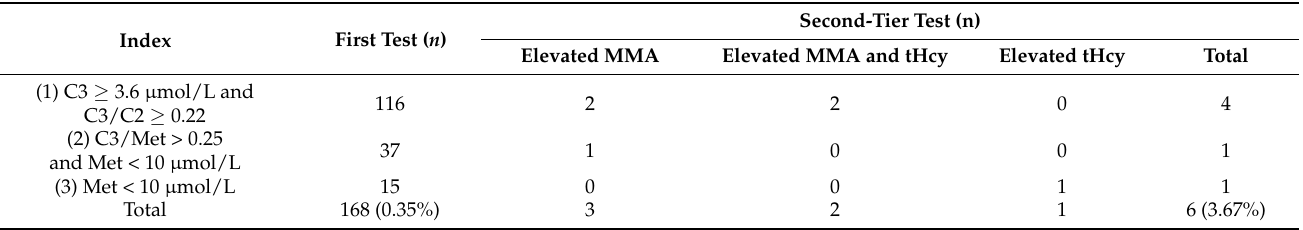
Table 3. Retrospective screening for disorders of cobalamin metabolism in 59,207 newborns in the Hiroshima area from